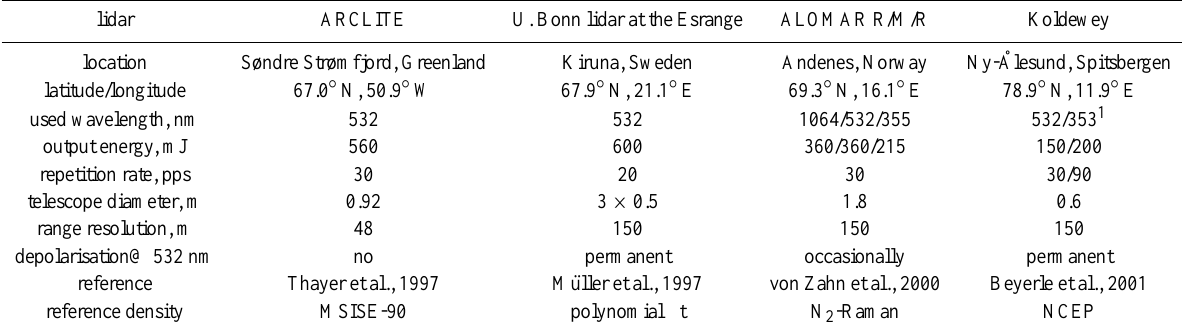
Table 1. Instrumental setup of the different lidar systems